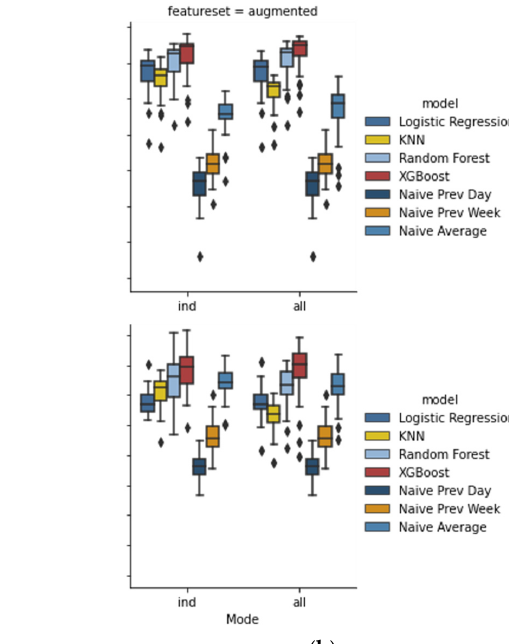
Each of the four models performs better on the median AUC score than the naïve